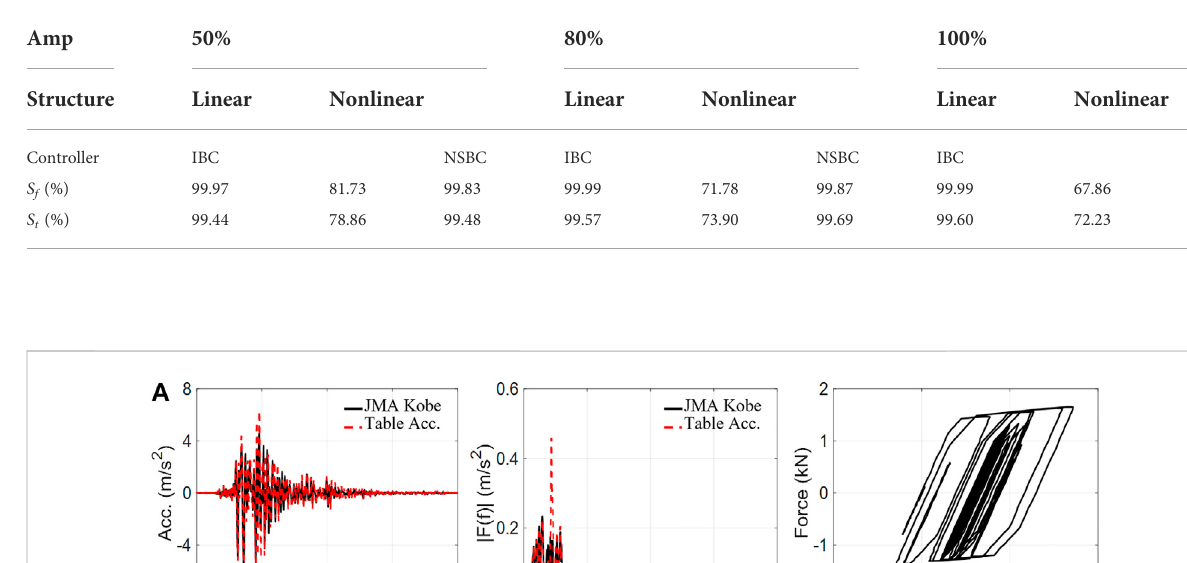
TABLE 1 Shake table control accuracies of IBC and NSBC in numerical simulations.